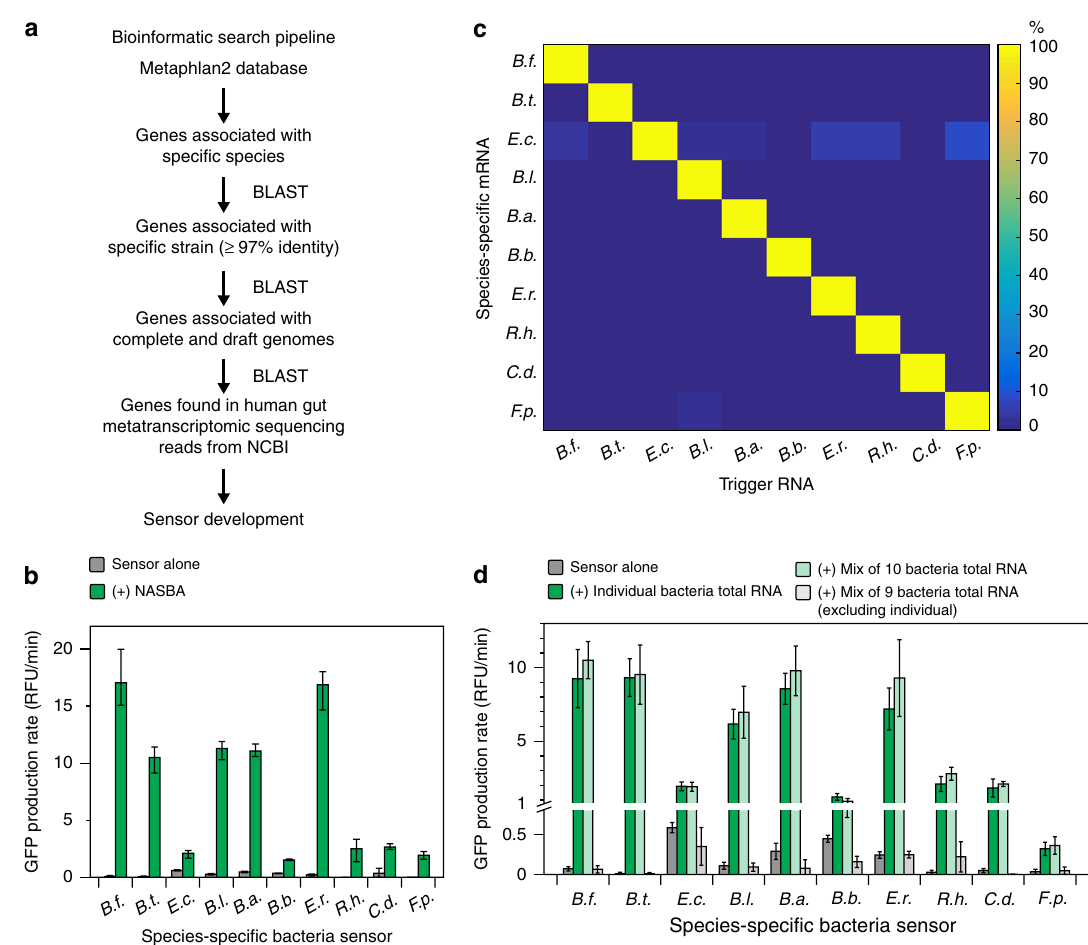
Fig. 3 Species-speci fi c mRNA sensors. a Bioinformatic pipeline for identifying species-speci fi c mRNAs. b Best performing NASBA primers and species- speci fi c mRNA sensors for each species. NASBA reactions were performed on 10 ng of total RNA for 90 min. Outputs from NASBA reactions were used to activate toehold switch sensors in paper-based reactions. Data represent mean values of three technical replicates. Error bars represent high and low values of the three replicates. c Orthogonality of species-speci fi c sensors. Each sensor was challenged with 2 μ M of trigger RNAs from each species representing what would be ampli fi ed in a NASBA reaction. GFP production rates for an individual sensor were normalized to the production rate of the sensor plus its cognate trigger (100%). Data represent mean values of six replicates (two biological replicates × three technical replicates). Full data and s.d. are shown in Supplementary Figure 6. d Orthogonality of NASBA primer sets. NASBA reactions were performed on 10 ng of total RNA for 90 min. Data represent mean ± s.d. of six replicates (two biological replicates (NASBA reactions) × three technical replicates (paper-based